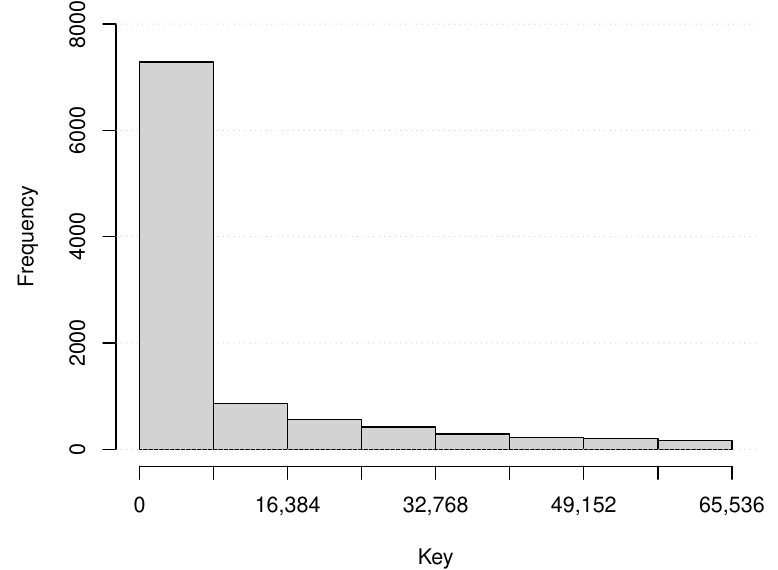
Figure 8. The number of messages among virtual nodes for one